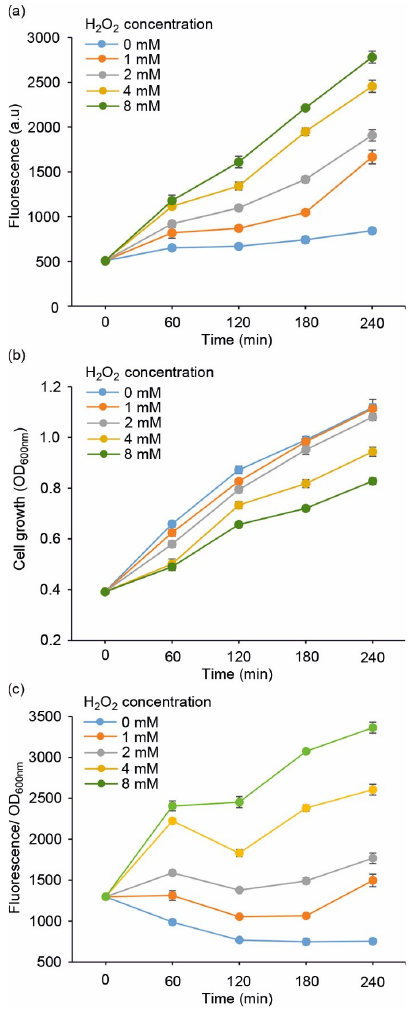
Figure 2. Evaluating the performance of E. coli DH5α /pJ404-IscR-C sensor system towards vary- ing concentrations of supplemented H 2 O 2 , monitored as ( a ) far-red E2-Crimson fluorescence, ( b ) cell growth (OD 600nm ), and ( c ) fluorescence normalised for growth at OD 600nm . The values were meas- ured at one-hour intervals from cell cultures repeatedly supplemented with H 2 O 2 corresponding to 1 mmol L −1 (orange line), 2 mmol L −1 (grey line), 4 mmol L −1 (yellow line), and 8 mmol L −1 (green line) every hour, in reference to cultures without H 2 O 2 (light blue line). The averages and standard deviations were calculated based on three independent parallel cultures with three technical repli- cates each ( n = 9). Due to small standard deviations, the error bars are not always visible.